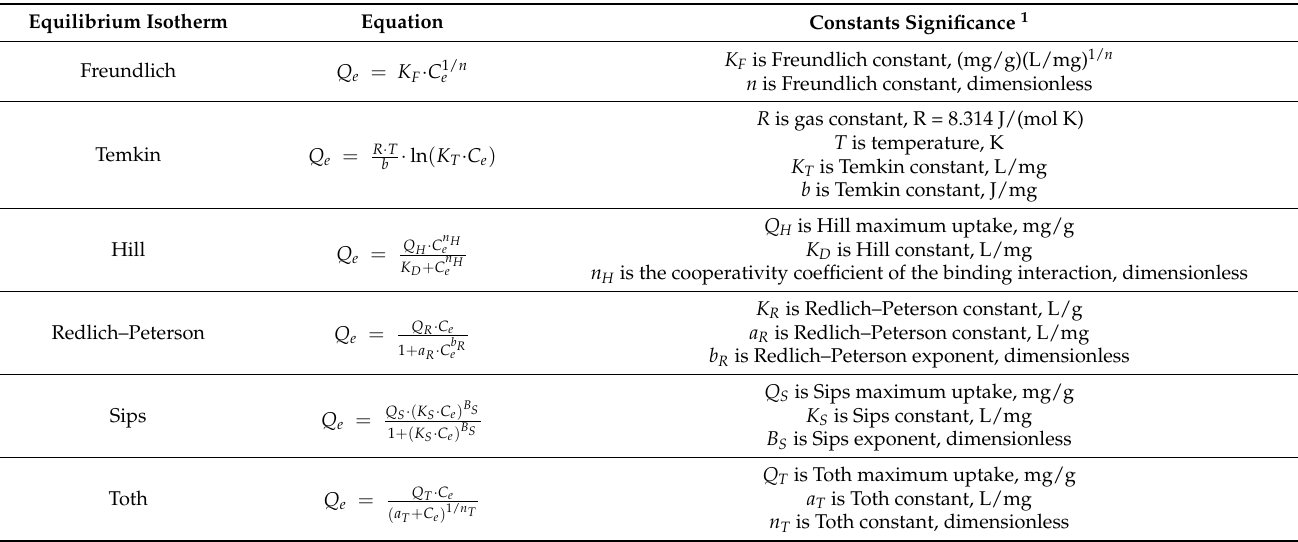
Table 2. Nonlinear equations of equilibrium isotherms.